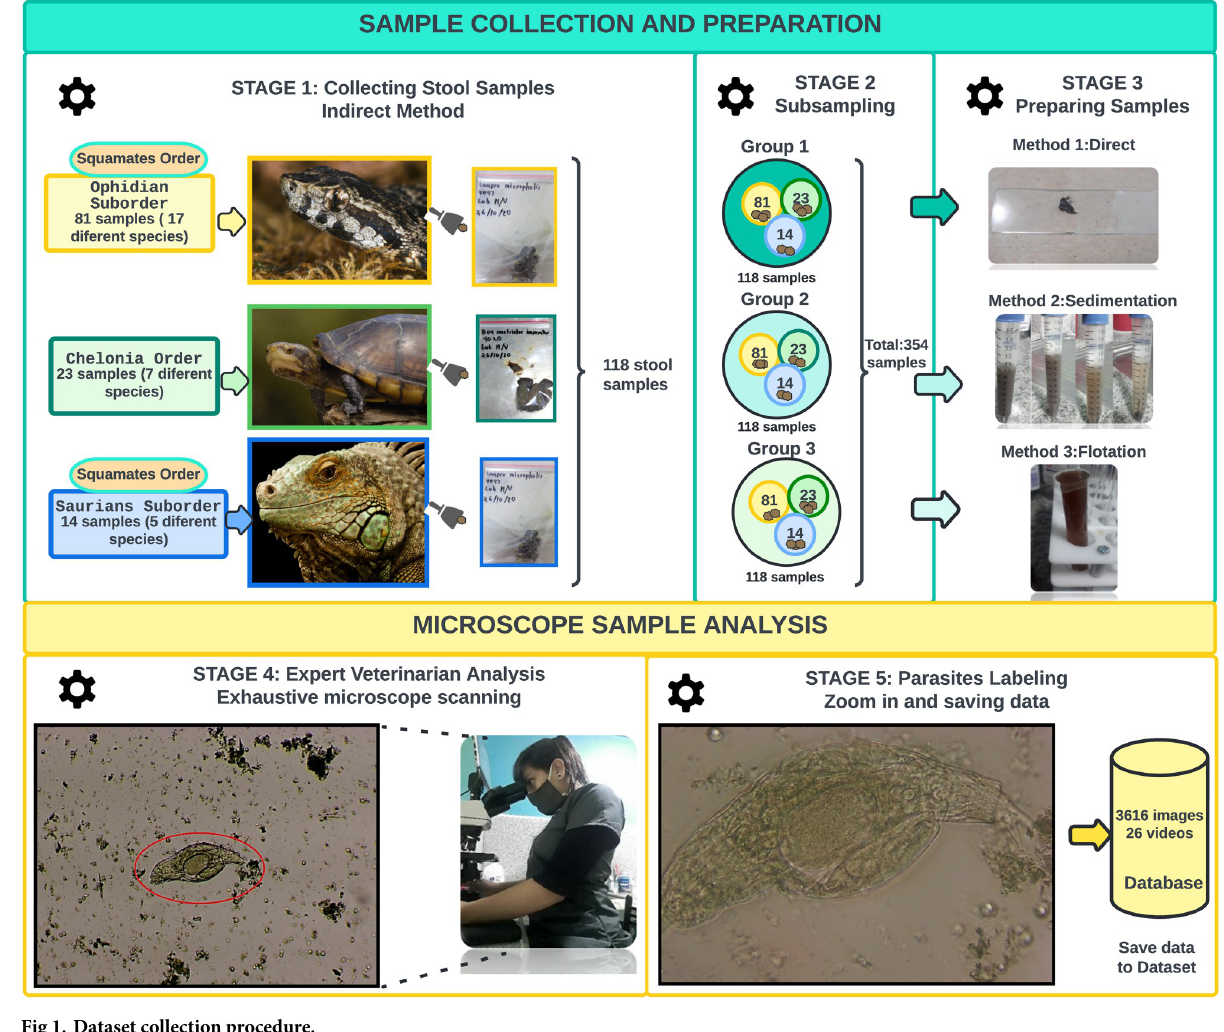
Fig 1. Dataset collection